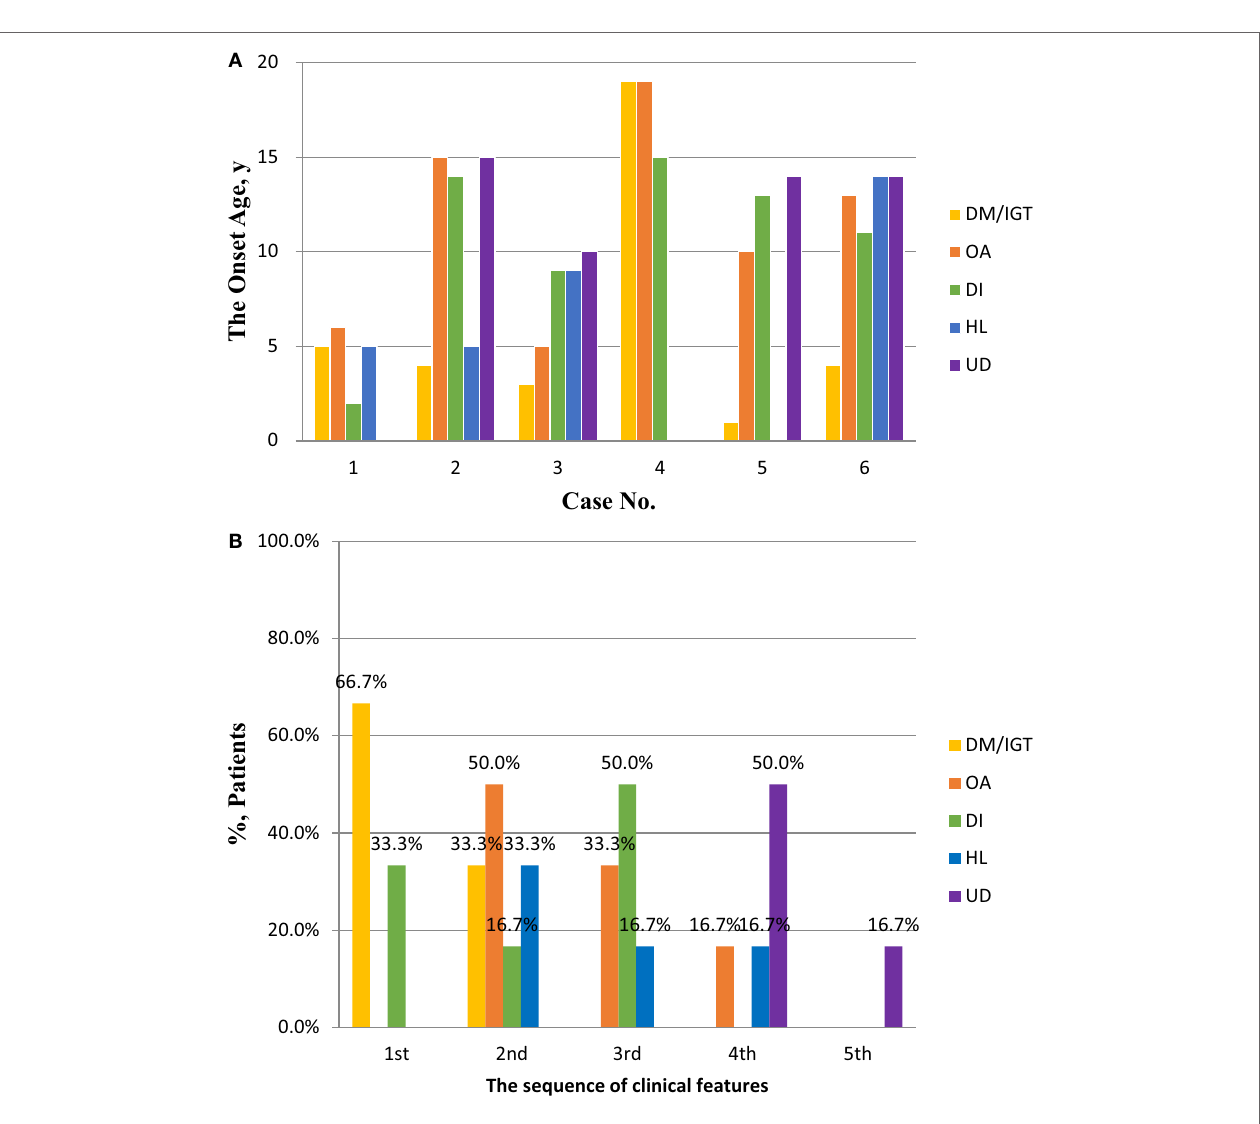
FigUre 1 | The onset ages and sequence of clinical features in patients with Wolfram syndrome (WS). (a) The onset ages of DM/IGT, OA, DI, HL, and UD in patients with WS. Detailed descriptive statistics are shown in Table S1 in Supplementary Material. (b) The sequence of DM/IGT, OA, DI, HL, and UD in patients